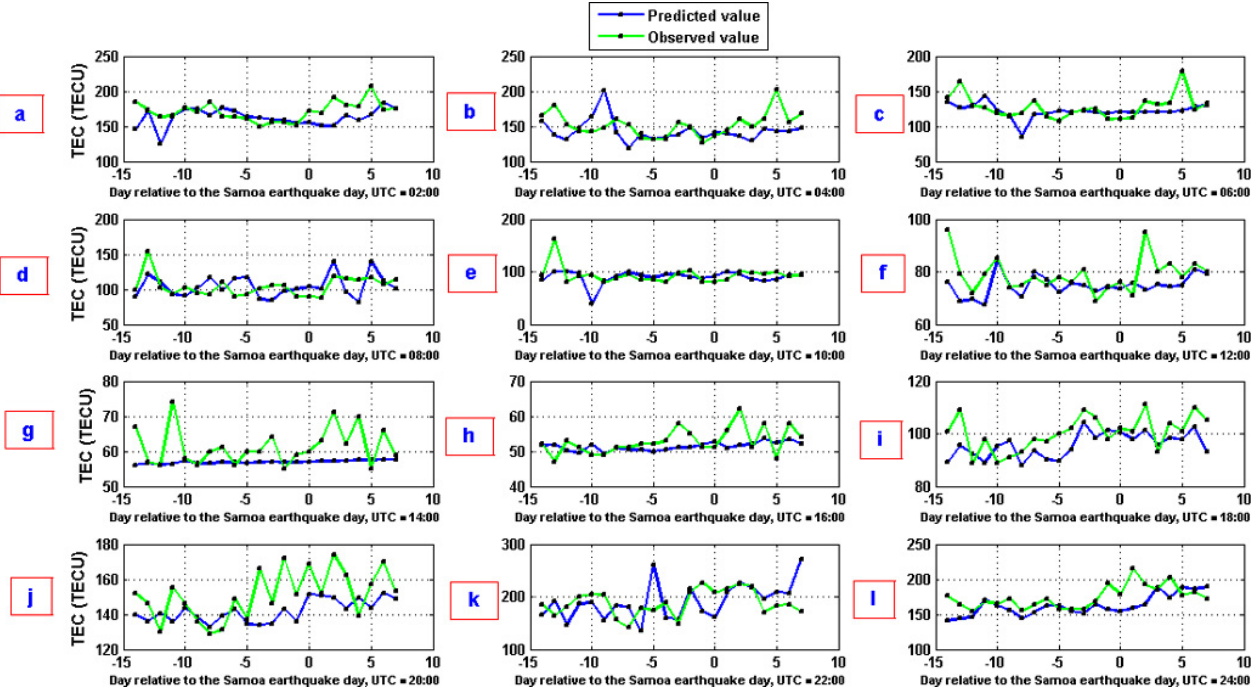
Fig. 13. Variations of the observed (green curve) and predicted (blue curve) TEC values on days selected as testing set at different universal times. The x-axis represents the day relative to the Samoa earthquake day but for the one year before the Samoa earthquake.